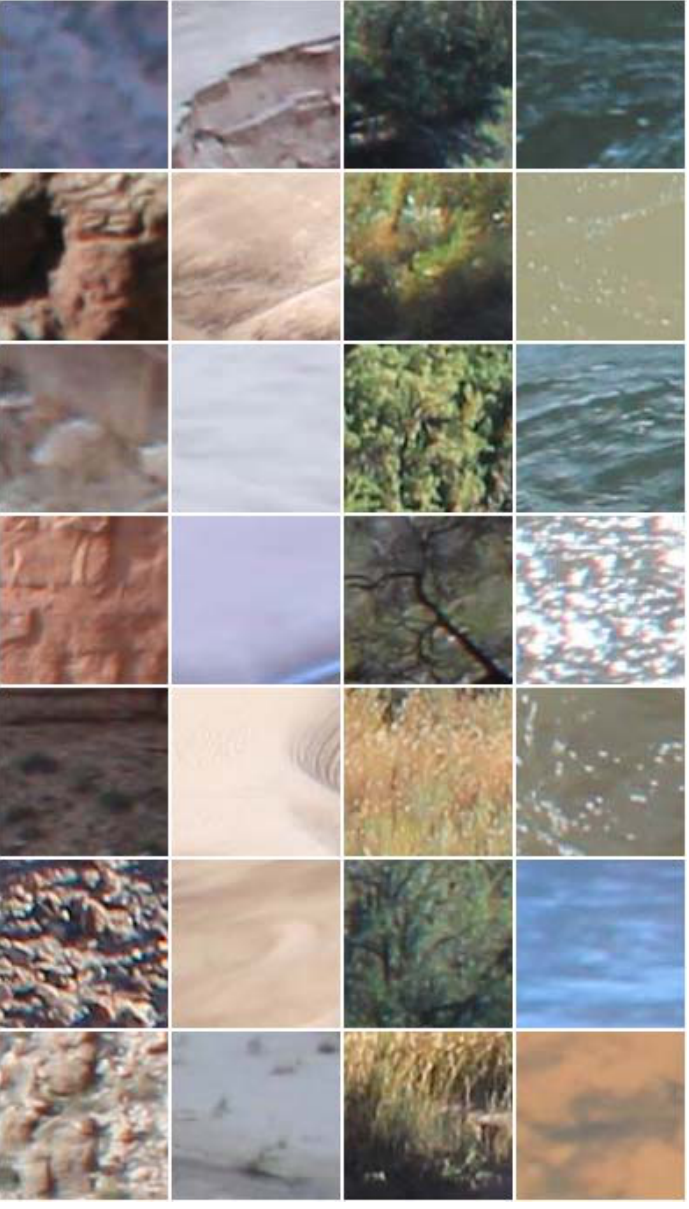
Figure 6. Example tiles from Grand Canyon. Classes, in columns, from left to right, are rock/scree, sand, vegetation, and water.